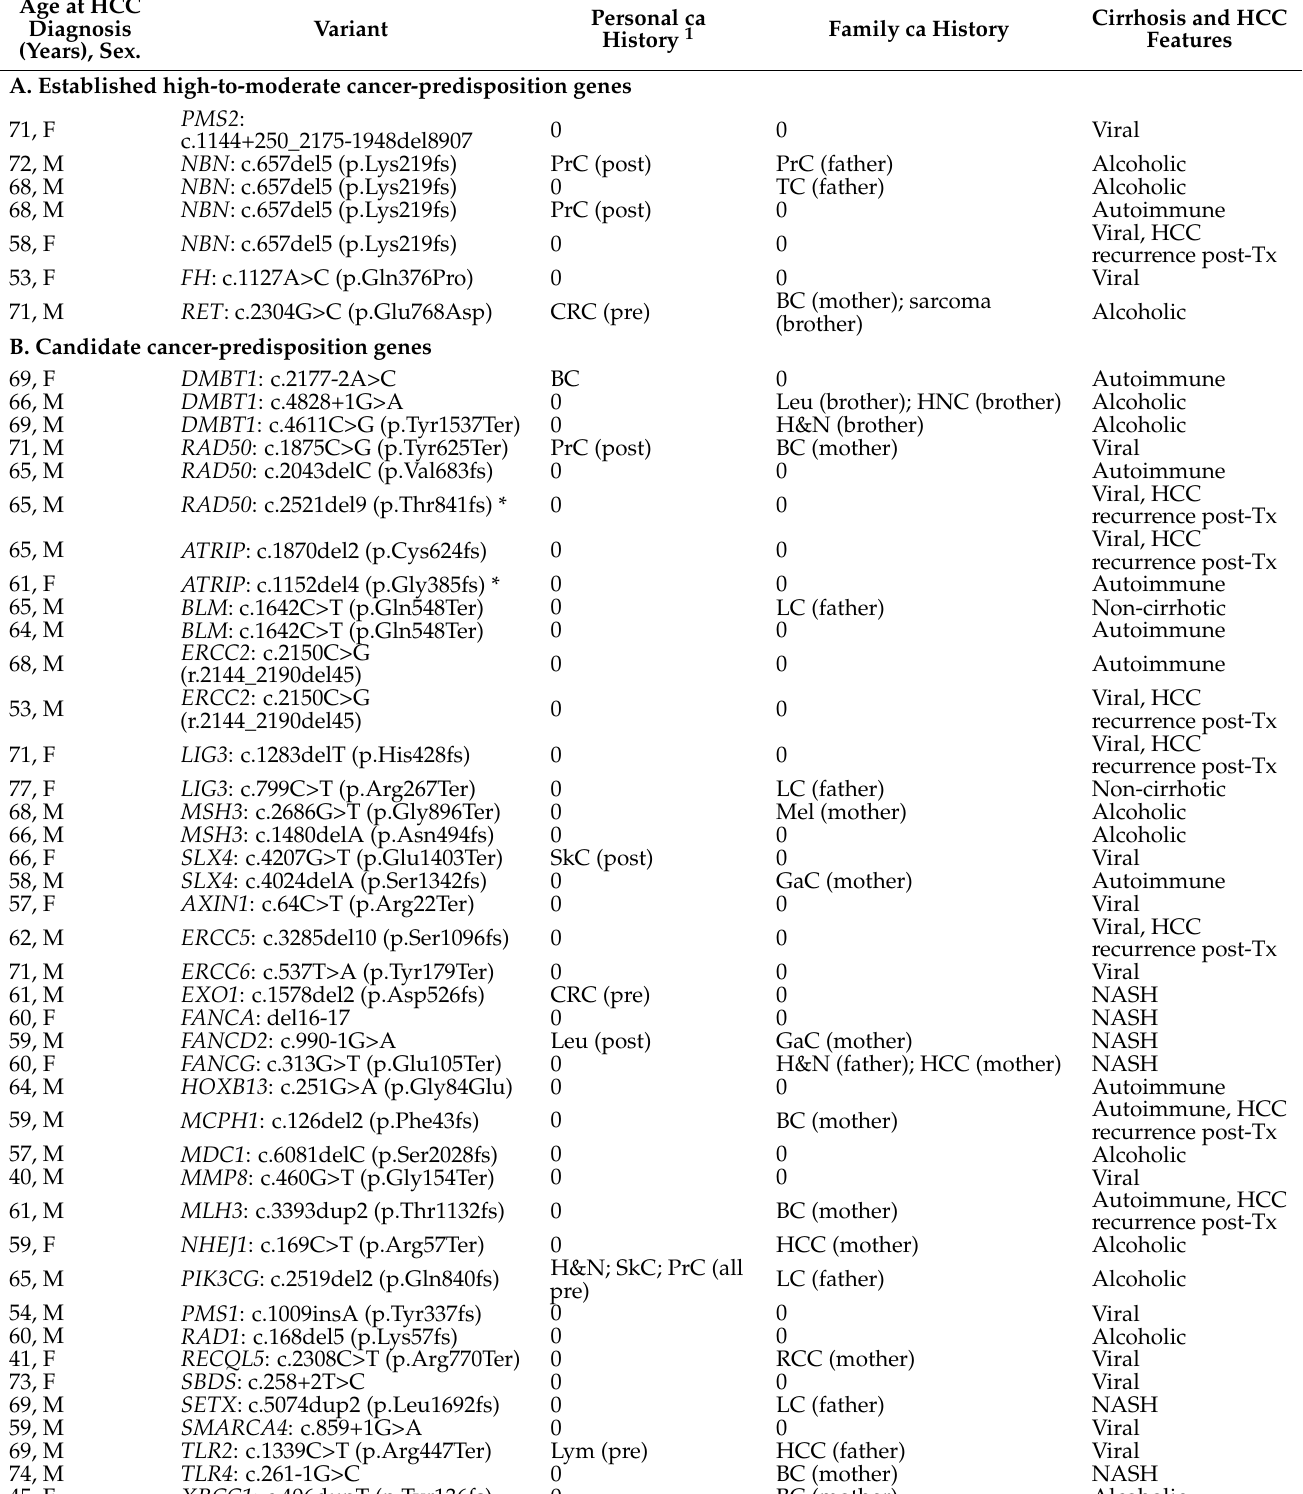
Table 2. Characterization of PV carriers with HCC in established high-to-moderate ( A ) and candidate ( B ) cancer predisposition genes. The PVs were present in the heterozygous state in all